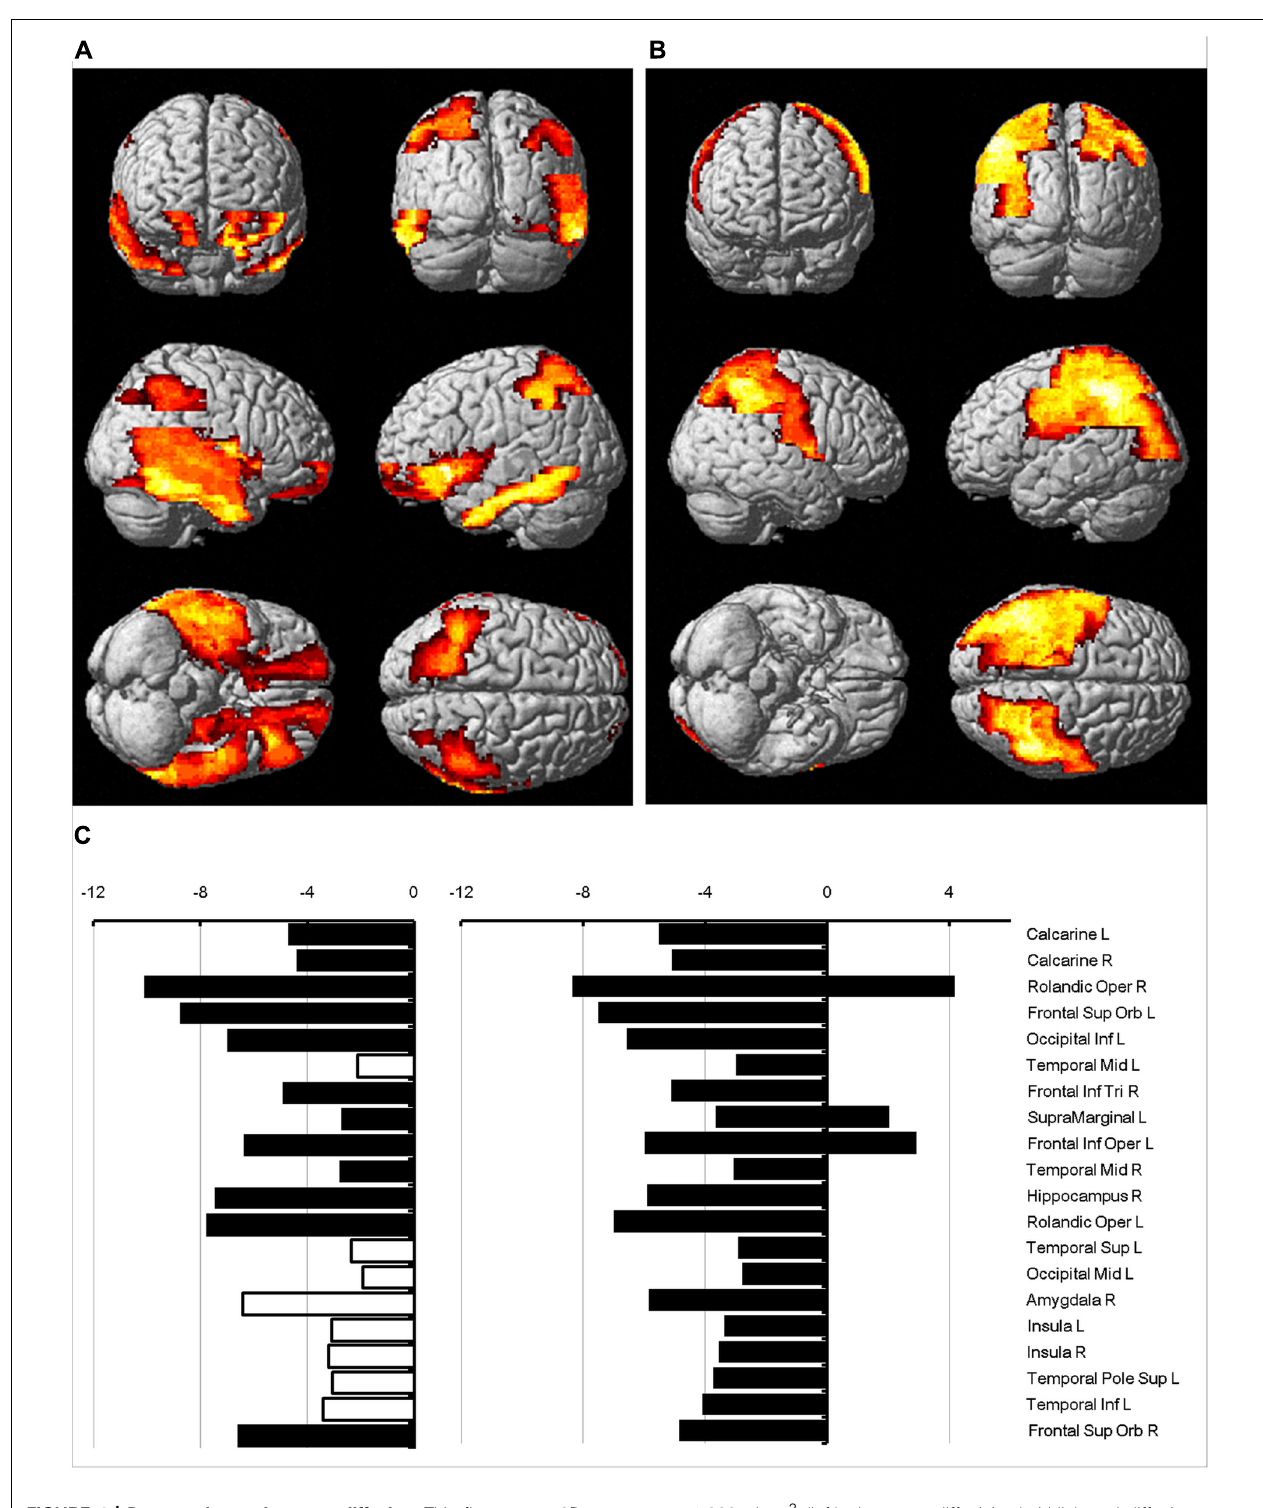
b = 1,000 s/mm 2 (left), the mean diffusivity (middle), and diffusion kurtosis (right) from regions with significance. The blank bar in the plot of the mean diffusivity calculated with b = 1,000 s/mm 2 indicates that the difference did not reach